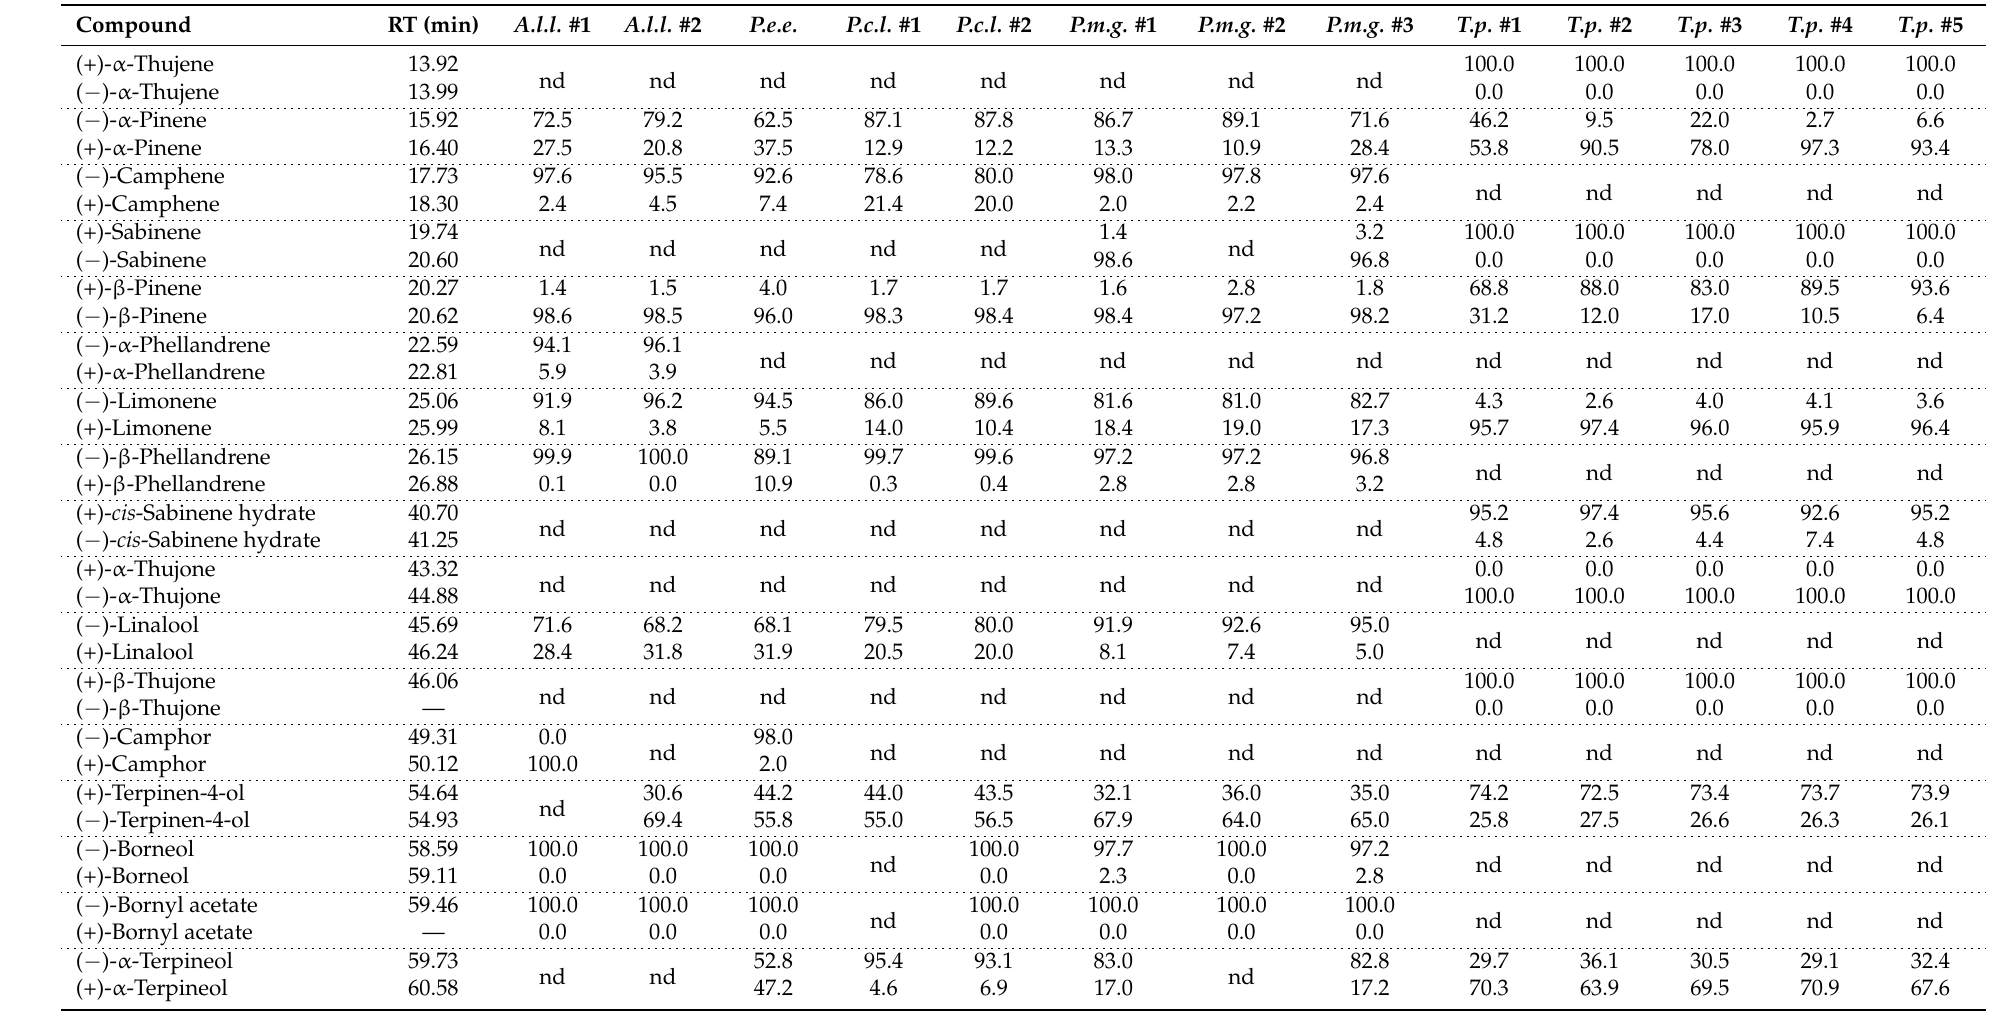
Table 6. Enantiomeric distribution of chiral terpenoid components (percentage of each enantiomer) in gymnosperm essential oils from